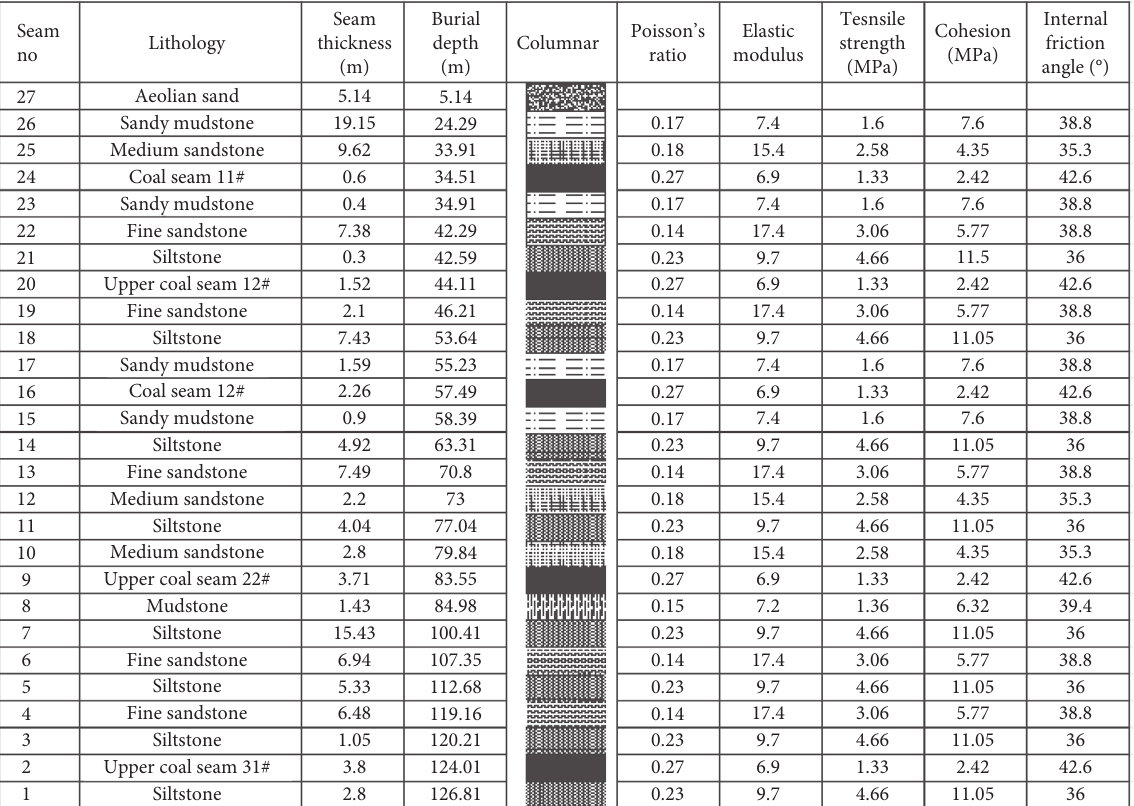
Figure 2: Macrophysical and mechanical properties of the coal seam and